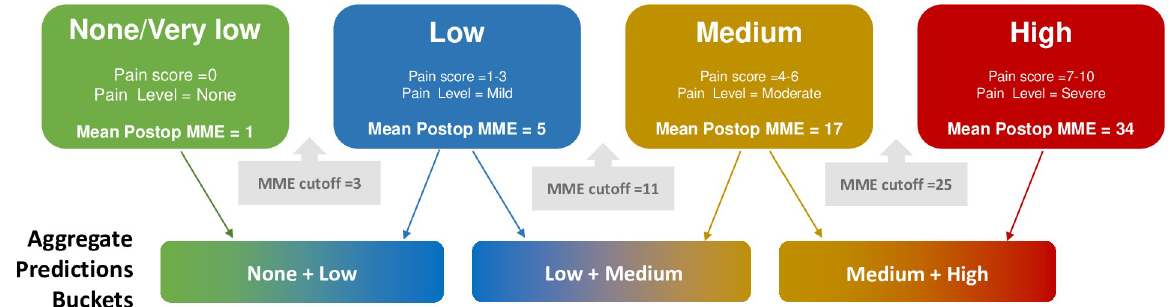
Fig 2. The concept of using aggregate model prediction for model validation is shown. The models predicted probabilities of postoperative opioid requirements in four buckets None/very low, Low, Medium and High. For model validation, the ability to predict within two adjacent buckets (None + Low, Low + Medium, Medium + High) was considered. The aggregate prediction bucket that had the highest combined prediction probability was considered as the model prediction. The predicted aggregate bucket was compared against the bucket corresponding to the actual opioid requirement for estimating the model